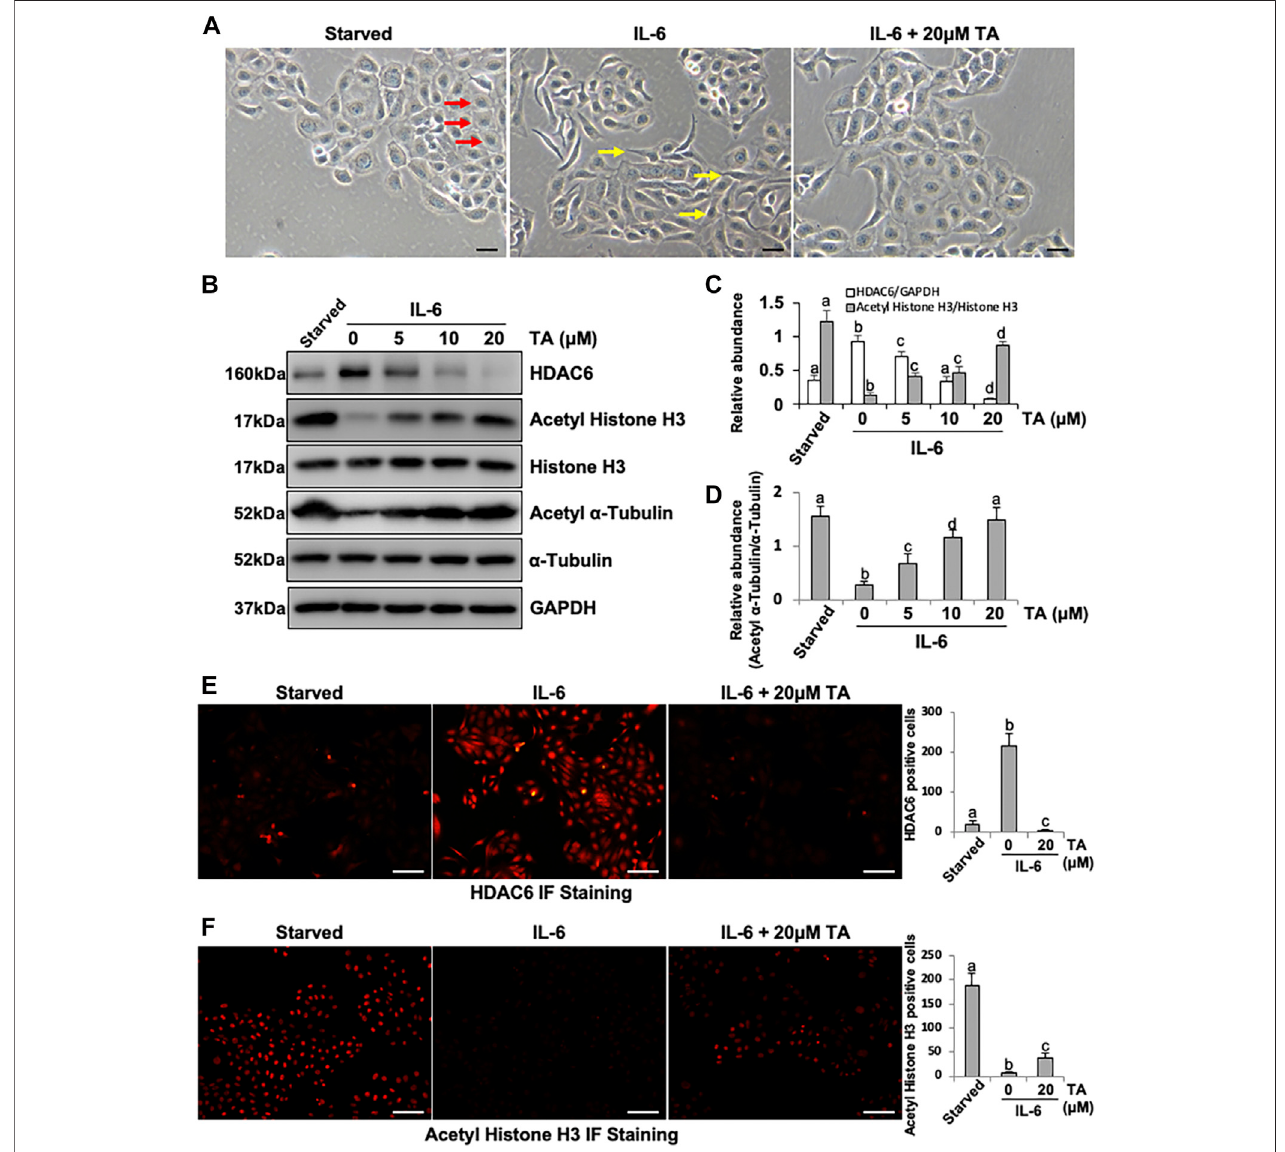
FIGURE1| IL-6increasestheexpressionofHDAC6inculturedhumanperitonealmesothelialcells. (A) Cellmorphologywasobservedusinglightmicroscopy.Red arrows indicate the cobblestone-shaped cells and yellow arrows show the spindle-shaped cells. (B) Cell lysates were subjected to immunoblot analysis with antibodies against HDAC6, Acetyl Histone H3, Histone H3, Acetyl α -Tubulin, α -Tubulin, and GAPDH. (C) Expression levels of HDAC6 and Acetyl Histone H3 were quanti fi ed by densitometry and normalized with GAPDH and total Histone H3, respectively. (D) Expression level of Acetyl α -Tubulin was quanti fi ed by densitometry and normalizedwith total α -Tubulin. Immuno fl uorescence photomicrographs ( × 200)illustrate stainingofHDAC6 (E) and Acetyl HistoneH3 (F) .In theHPMCs underdifferent treatment, the count of HDAC6 or Acetyl Histone H3 positive cells was calculated from 10 random fi elds of each cell sample. Data are represented as the mean ± SEM (n (cid:1) 3). Means with different superscript letters are signi fi cantly different from one another ( p < 0.05). All scale bars (cid:1) 100 μ m.